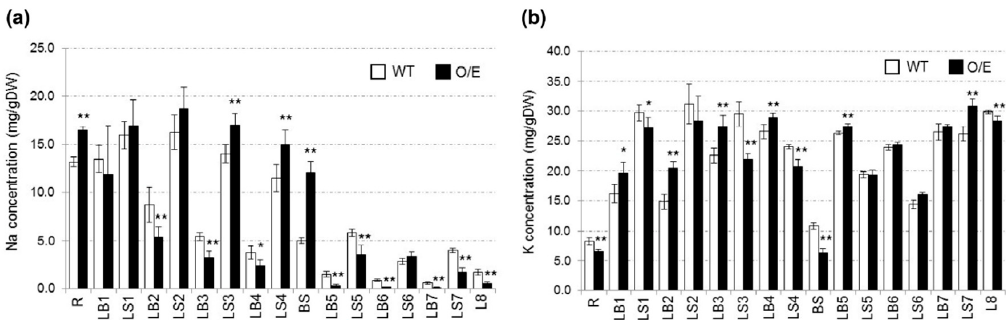
Figure 2. Measurements of Na and K concentrations using O/E and wildtype lines (WT) plants, which were subjected to salt stress. Plants were prepared by hydroponic culture, and 3 to 4-week-old plants were treated with 50 mM NaCl for 24 h. ( a ) Na concentrations in leaves, basal stems and roots; ( b ) K concentrations in the same tissues as in ( a ). LB, LS, BS and R represent, respectively, leaf blades, leaf sheaths, basal stems and roots. Larger numbers on LB and LS represent younger leaves. Asterisks indicate significant differences between O/E and WT plants (Student’s t -test: * p < 0.05, ** p < 0.01; n = 4, ± SD).